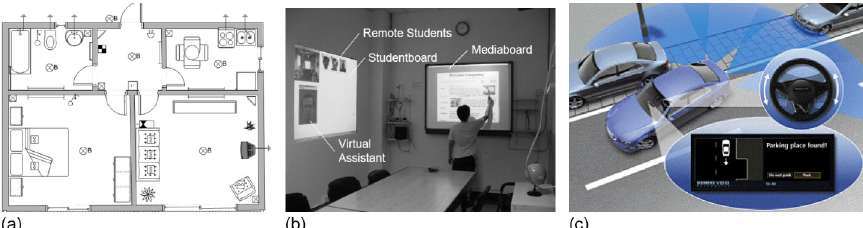
Figure 3. Intelligent Environments, from left to right: (a) Smart Homes [23], (b) Smart Classrooms [24], (c) Smart Cars (Courtesy of